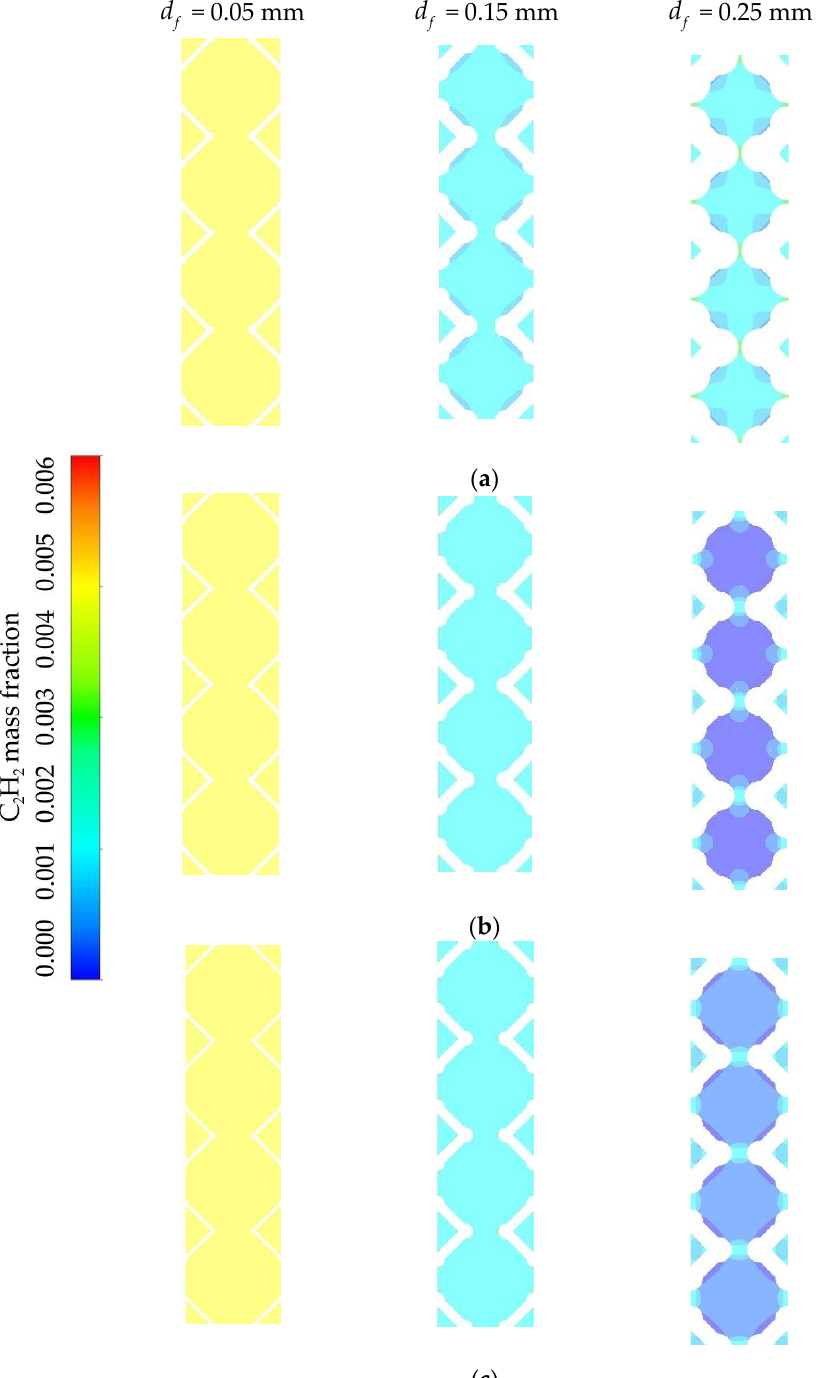
Figure 11. The mass content of the C 2 H 2 component in the porous medium for different values d c and d f at T in = 45 ◦ C: ( a ) d c = 2.0 mm. ( b ) d c = 2.5 mm. ( c ) d c = 3.0 mm.